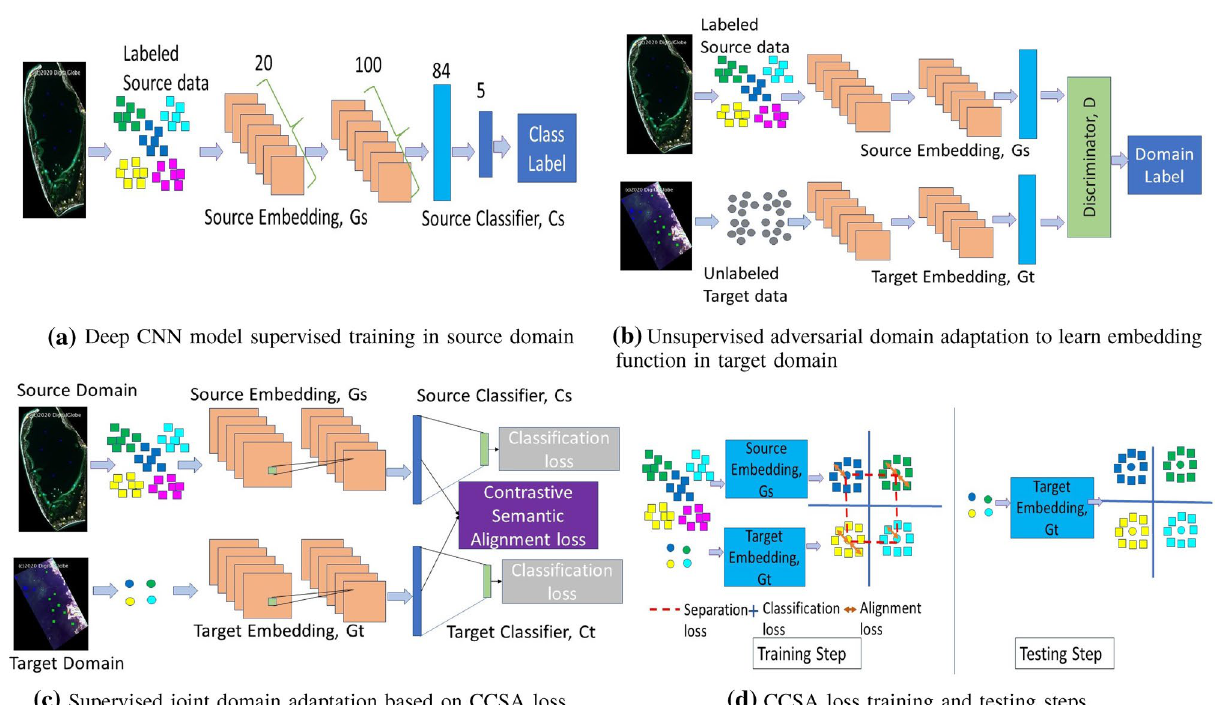
Fig. 2 Proposed semi-supervised domain adaption